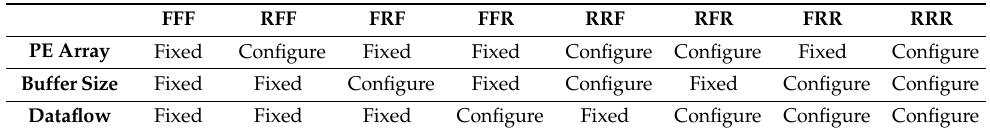
Table 2. Definition of